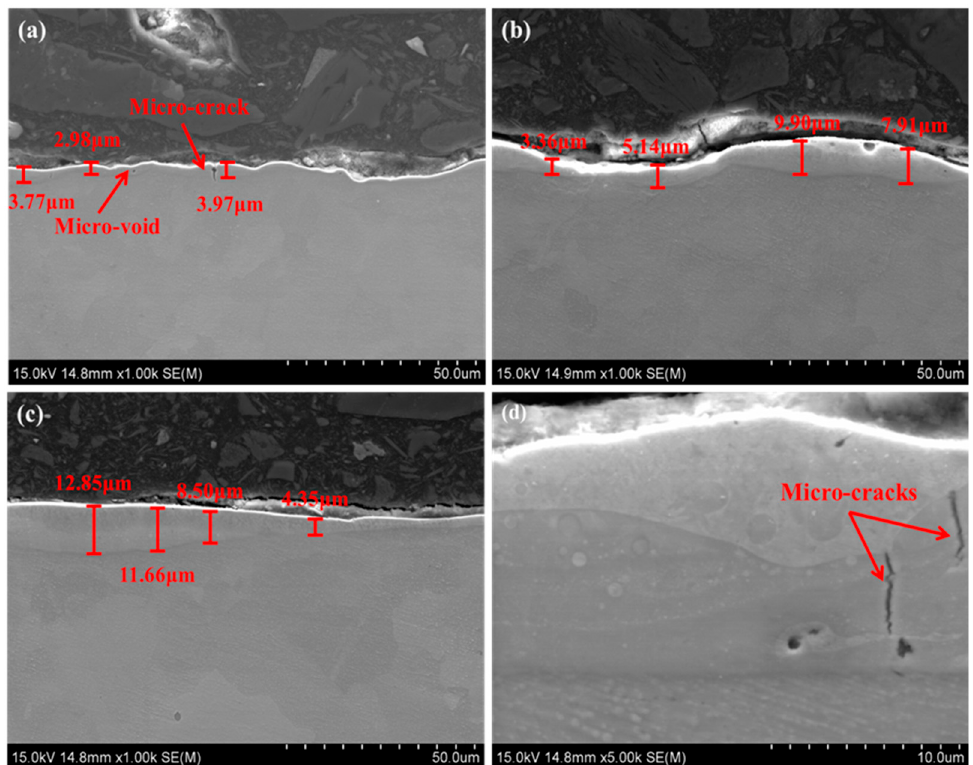
Figure 6. Cross-section of EDMed surfaces showing the thickness of the white layer: ( a ) I p = 5 A, T on = 12.8 μ s and AWLT = 3.57 μ m, ( b ) Ι p = 7A, T on = 50 μ s and AWLT = 6.58 μ m, ( c ) I p = 9 A, T on = 50 μ s and AWLT = 9.38 μ m and ( d ) I p = 9 A, T on = 50 μ s.